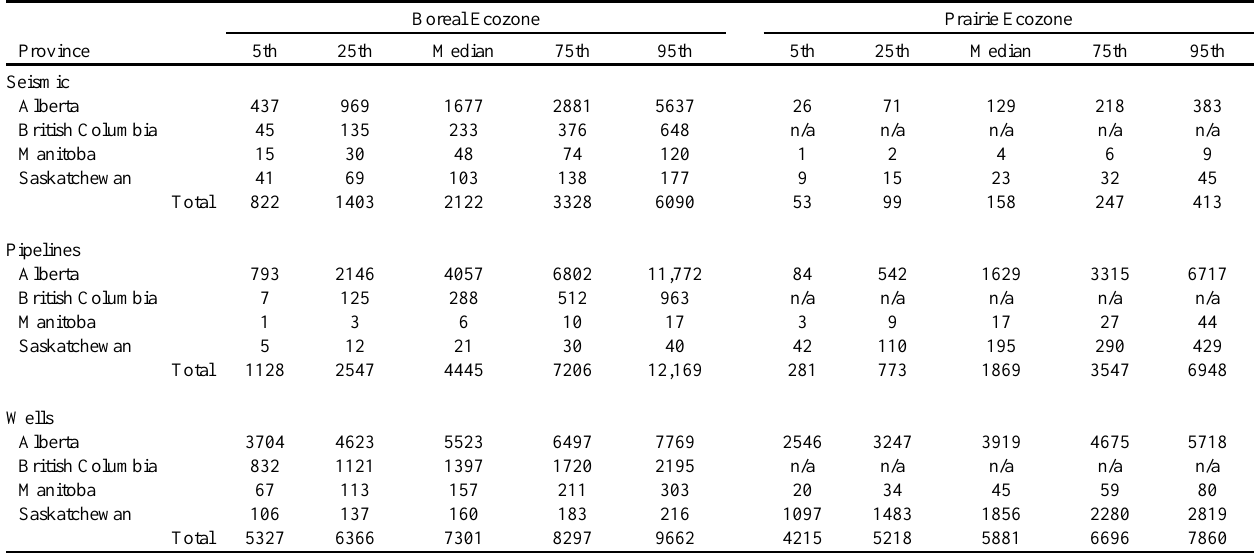
Table 3 . Estimated numbers of bird nests lost annually because of pipeline, seismic line, and well site construction during the migratory bird breeding season for the boreal and prairie ecozones within the Western Canadian Sedimentary Basin. Estimates represent percentiles of 50,000 Monte Carlo simulations incorporating variance associated with differing assumptions regarding amount and timing of disturbance relative to the breeding season, nest densities, and interannual variation in industrial activity (see Methods). Boreal Ecozone Prairie Ecozone